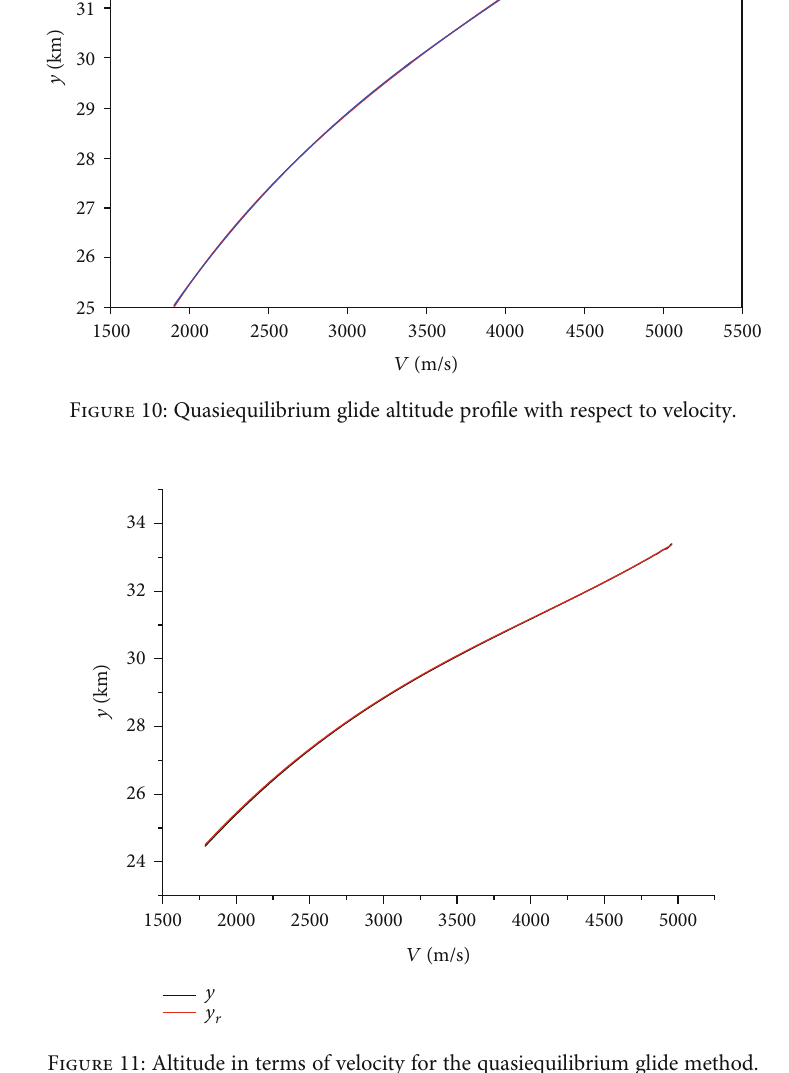
Figure 11: Altitude in terms of velocity for the quasiequilibrium glide